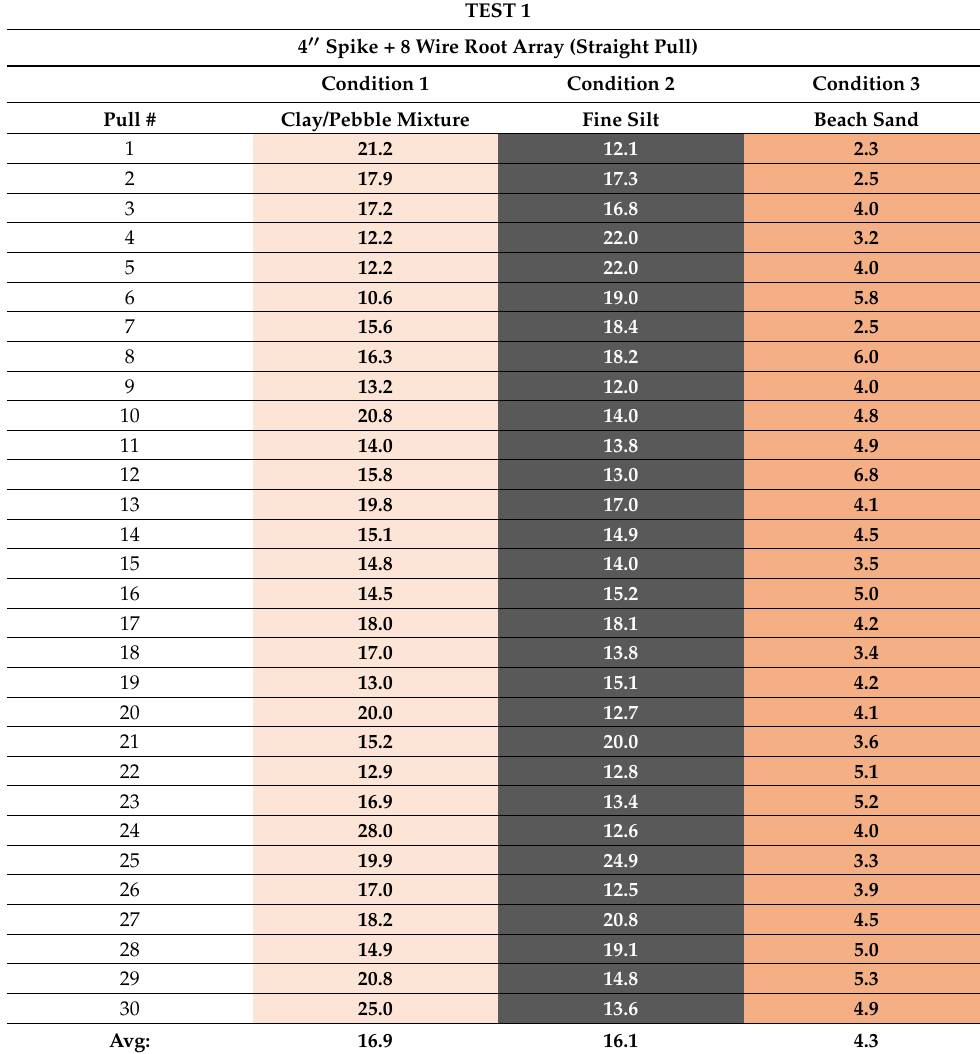
Table A1. Test 1: complete anchoring failure tension data